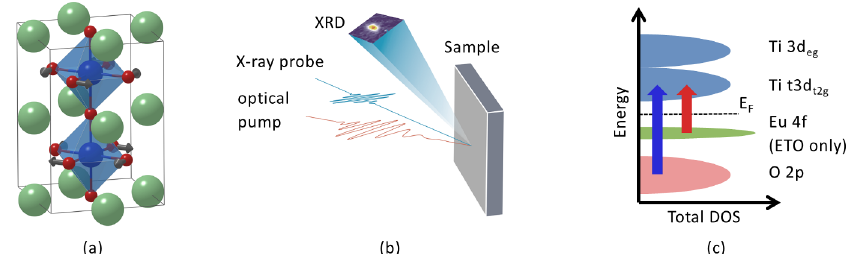
Figure 1. (a) Distorted unit cell of ETO / STO (Eu / Sr: green; Ti: blue; O: red). Arrows highlight the atomic motions towards the antiferrodistortive phase. (b) Schematic of the optical-pump / x-ray-probe experiments. (c) Optical excitation pathways and schematic location of the bands for ETO and STO (after